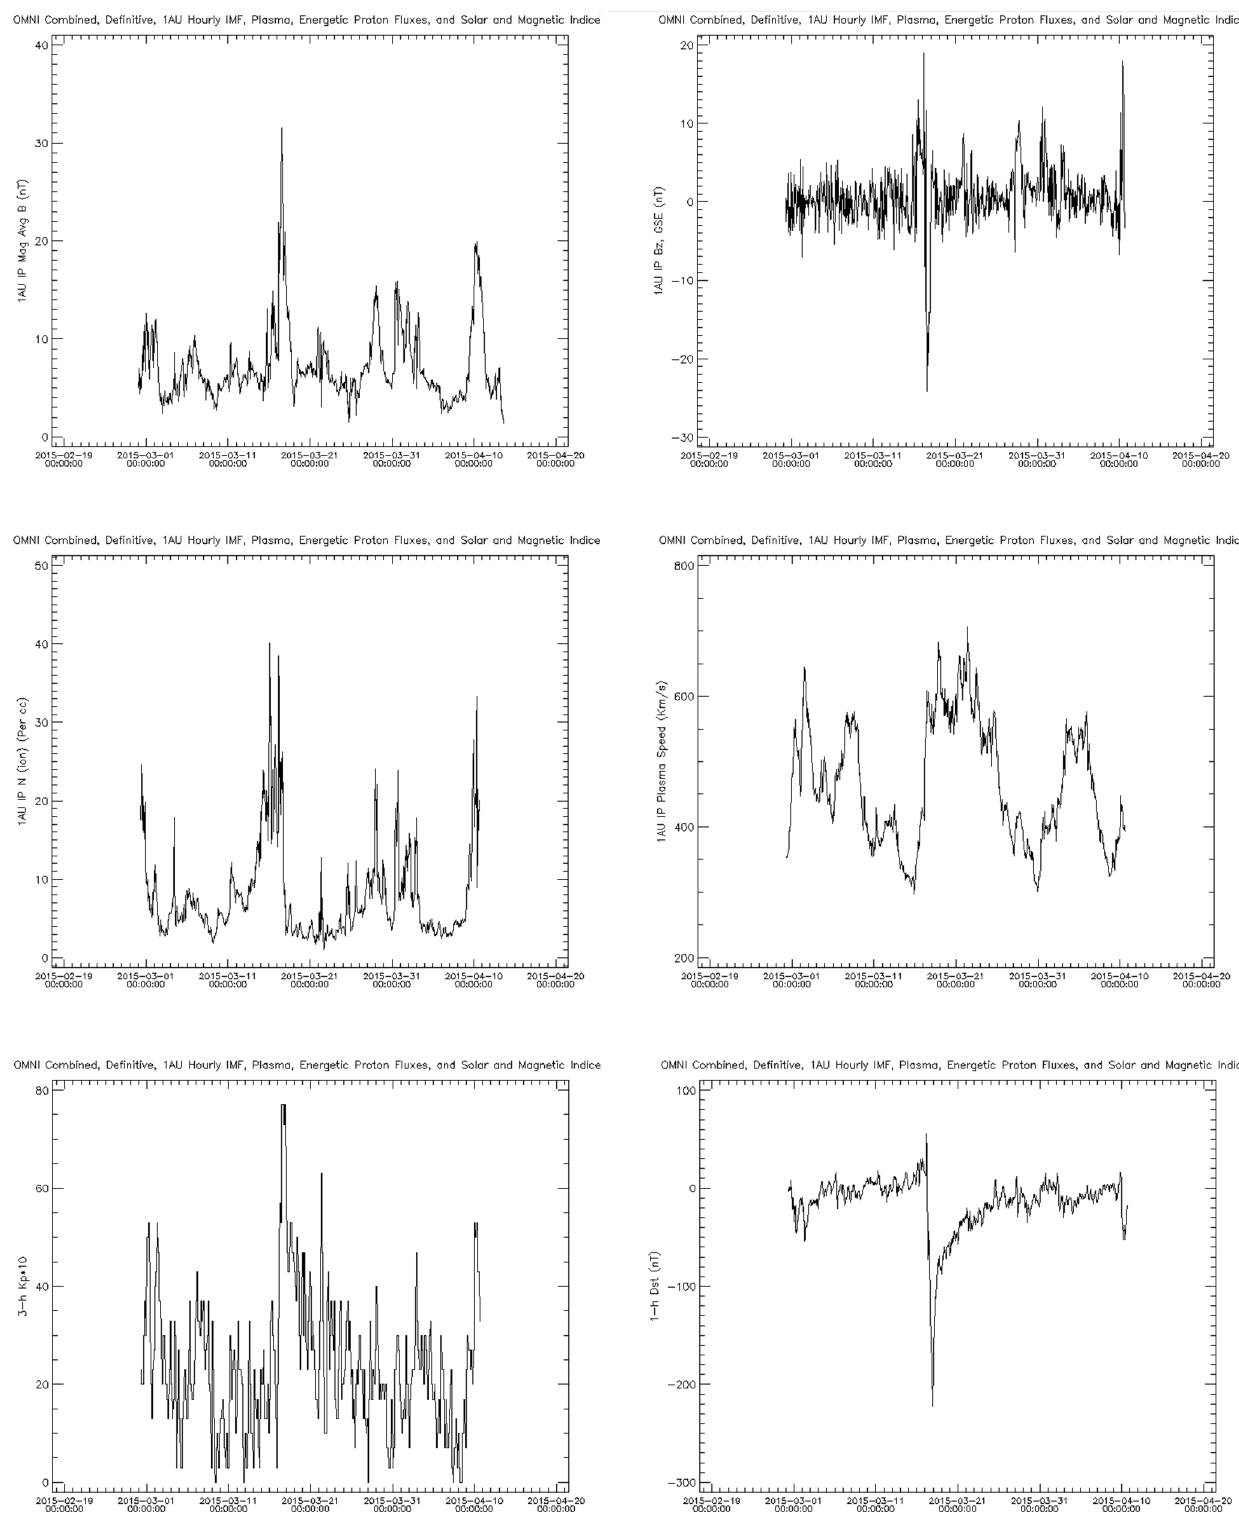
Figure 1. Parameters of the solar wind measured by ACE (respectively IMF intensity B in nT, B z (the z component of IMF in nT), density n in cm − 3 , bulk velocity u in kms − 1 ) and geomagnetic activity indices (respectively Kp and Dst in nT) observed between 28 February and 11 April